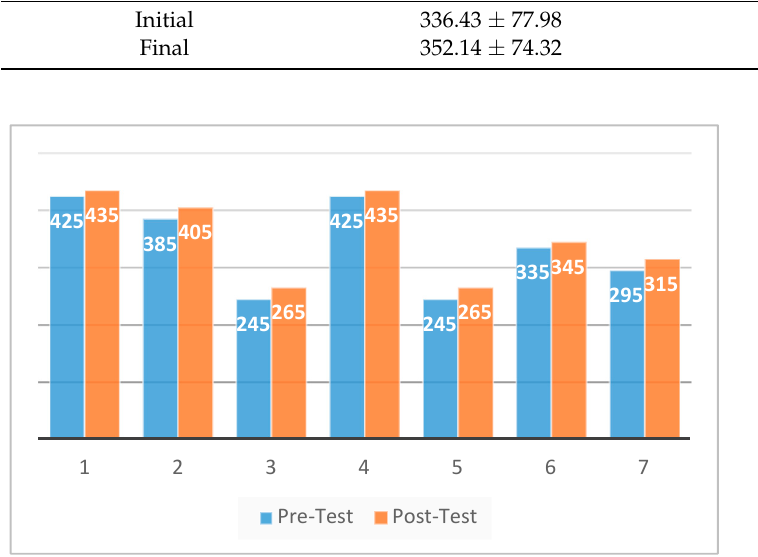
Figure 1. HBD 3RM 4-week testing results. ( p ≤ 0.001).